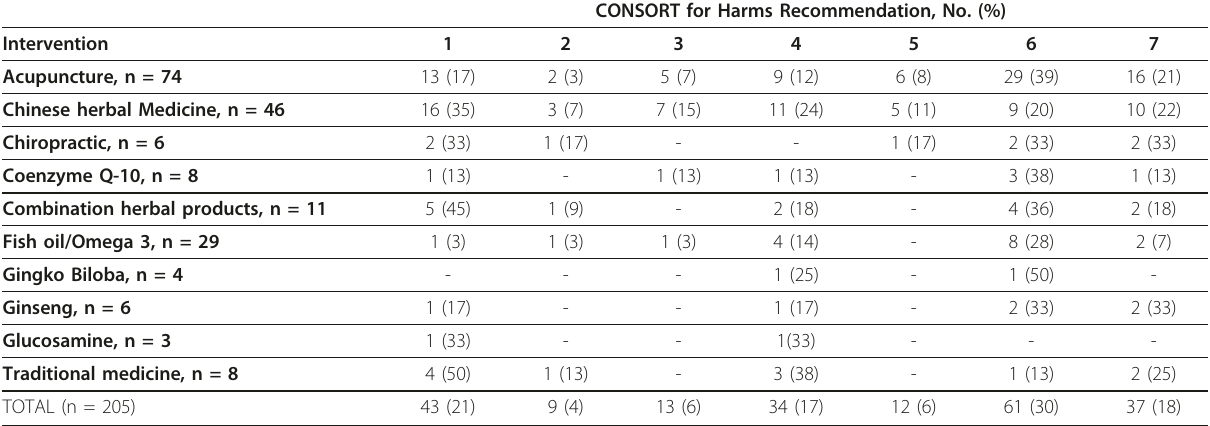
Table 4 Reporting of Safety in accordance with CONSORT for Harms Recommendations CONSORT for Harms Recommendation, No.